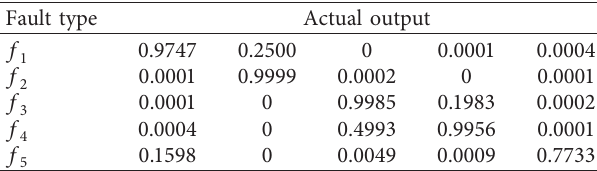
Table 7: COM-MCPSO-BP neural network diagnosis results. Fault type